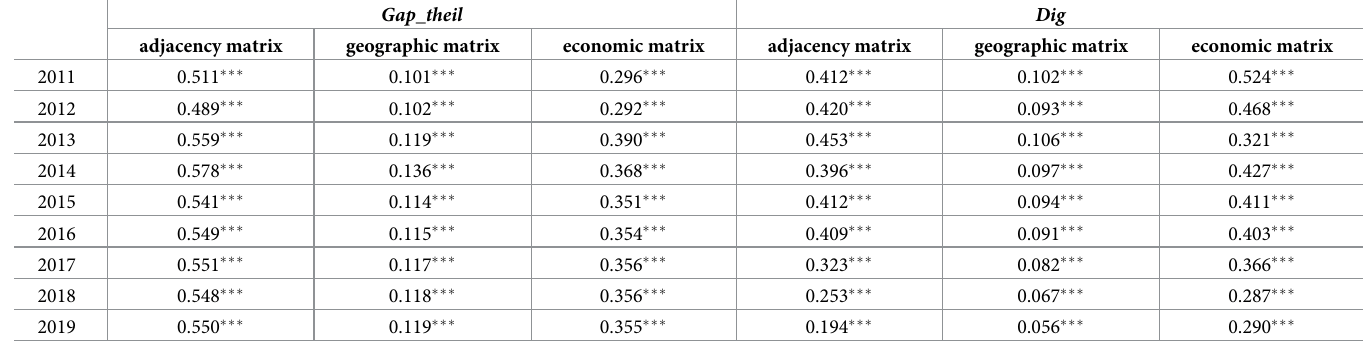
Table 6. Moran index test for spatial correlation.